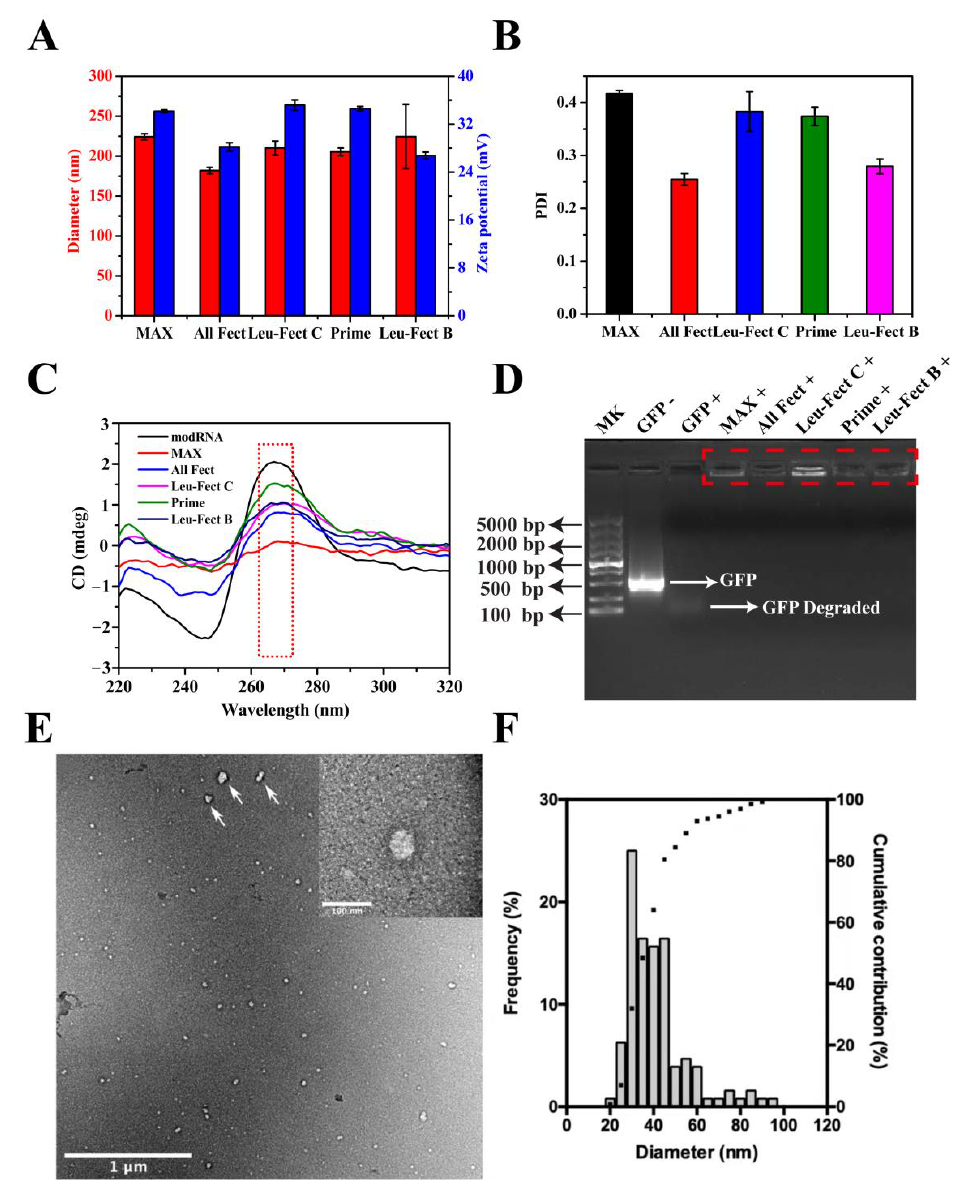
Figure 1. Characterization of complexes obtained from lipopolymers. ( A ) Size distribution and zeta potential of modRNA complexes with indicated polymers measured by the dynamic light scattering. Data represent mean ± SD ( n = 3). ( B ) The PDI of modRNA/polymer complexes. Data represent mean ± SD ( n = 3). ( C ) Conformation stability of modRNA complexes with various polymer by circular dichroism spectrometry. ( D ) Agarose gel electrophoresis assay of modRNA stability in vectors.+: contains 10% serum, -: no serum. ( E ) TEM micrograph of ALL-Fect complexes formed with modRNA (modRNA: ALL-Fect ratio of 1:5; scale bars = 1 µm and 100 nm in insert) and ( F ) particle size distribution obtained from representative TEM micrographs.